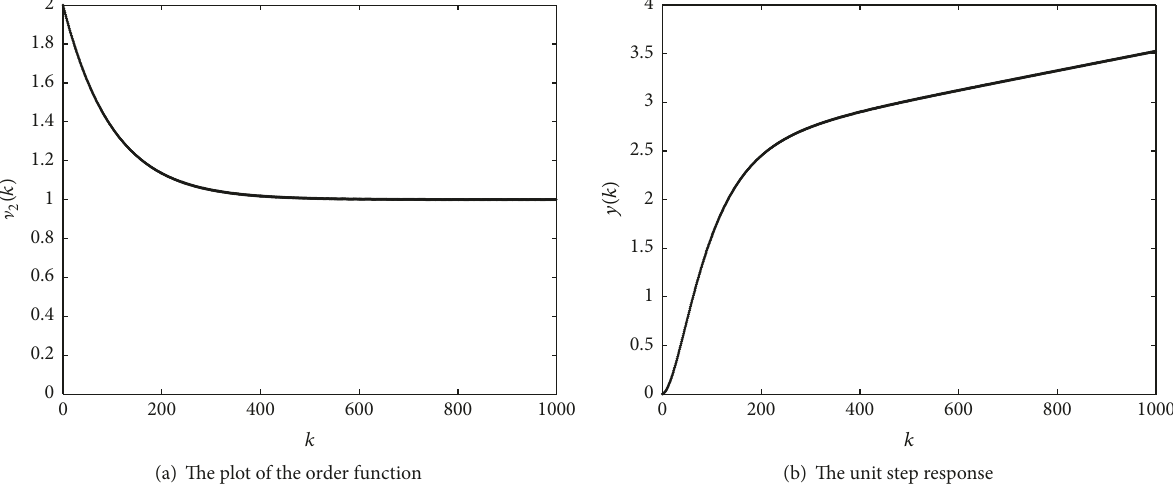
Figure 6: Plots of the order function ] 2 given by (36) and the unit step response of the 1st form of VFODI represented by formula (34) with 𝑏 = 0.001, 𝑘 = 0 . 0 0